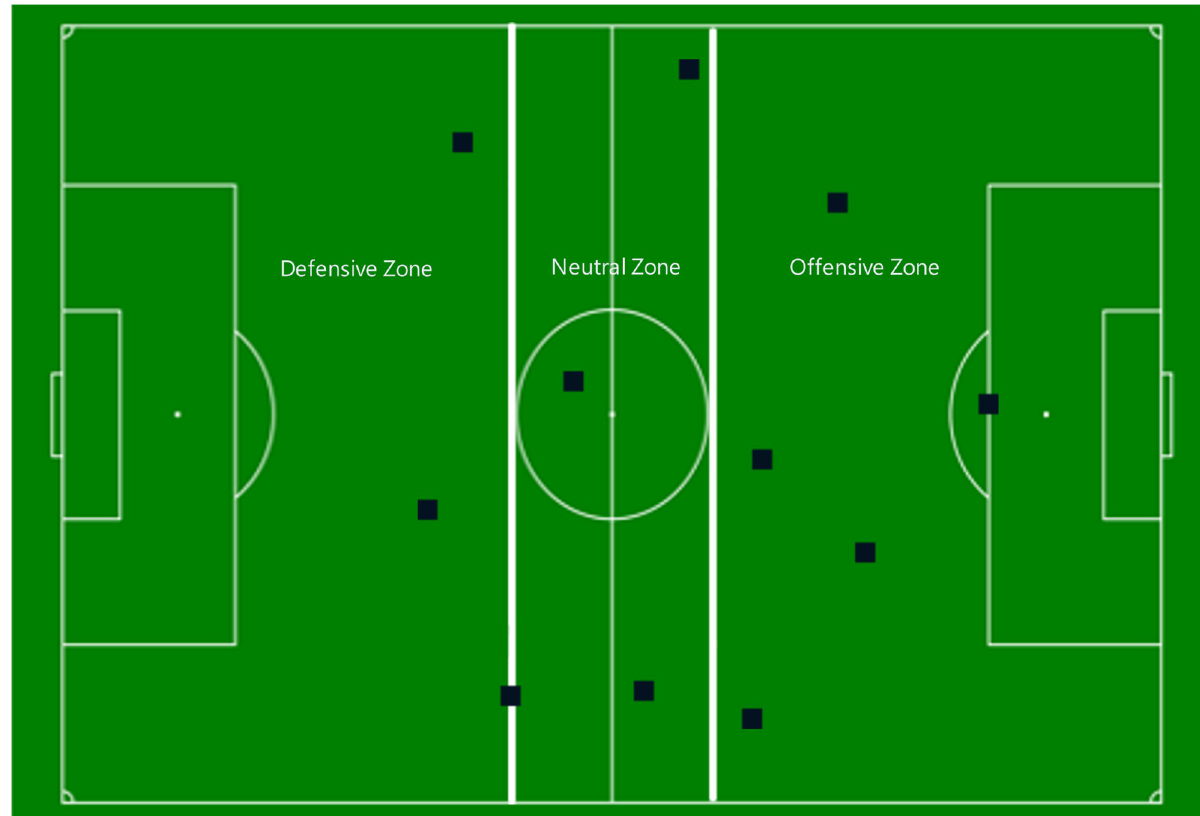
Fig 1. Zones and number of defensive players in the offensive zone. The direction of the attack would be left to right. Black squares represent defensive players. The defensive density in this example would be